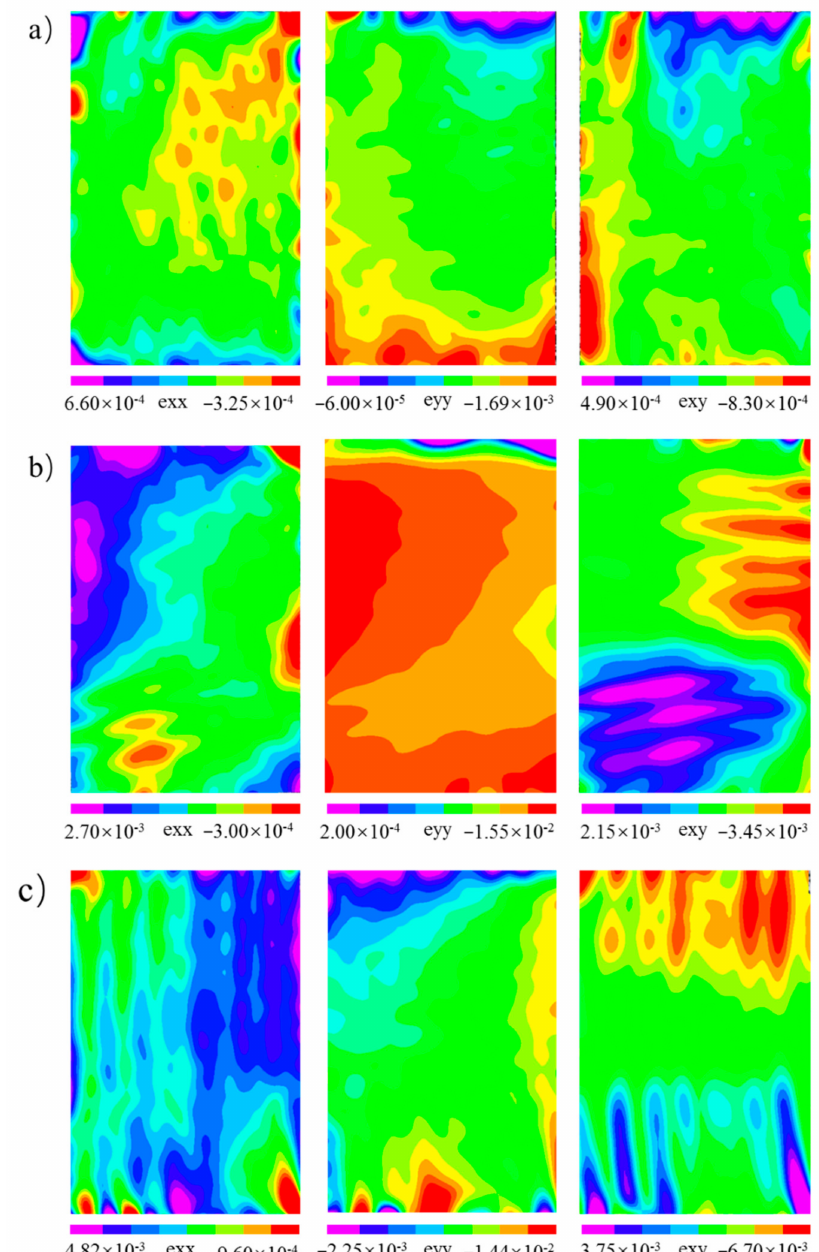
Figure 8. The distribution of the strain field in the elastic stage ( F = 1.60 kN): ( a ) longitudinal direction; ( b ) radial direction; ( c ) tangential direction. Note: In the figures, exx represents the strain perpendicular to the load direction, eyy represents the strain parallel to the load direction, and exy represents the shear